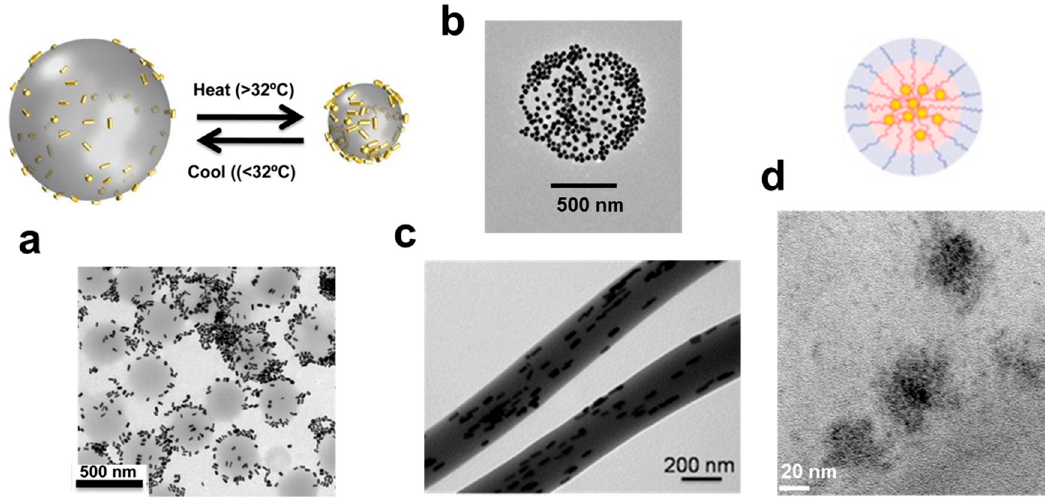
Figure 2. Examples of Au-PNIPAm based thermosensitive nanosystems ( a ) Schematic representation and TEM image of Au nanorods (NRs)–PNIPAm microgel hybrids and the corresponding thermoresponsive behavior ( b ) TEM image of PNIPAm–Au composite ( c ) TEM image of AuNRs/PNIPAm electrospun fibers. ( d ) Schematic representation and TEM image of Au-thermosensitive polymer (PEG-PNIPAm) nanohybrids. Reproduced with permission from